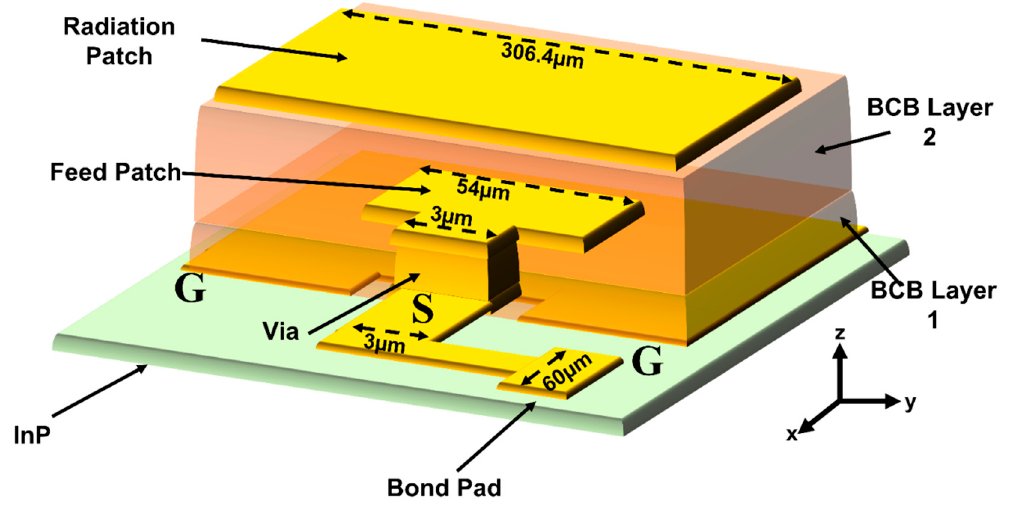
Figure 2. 3D structure of the unit cell.